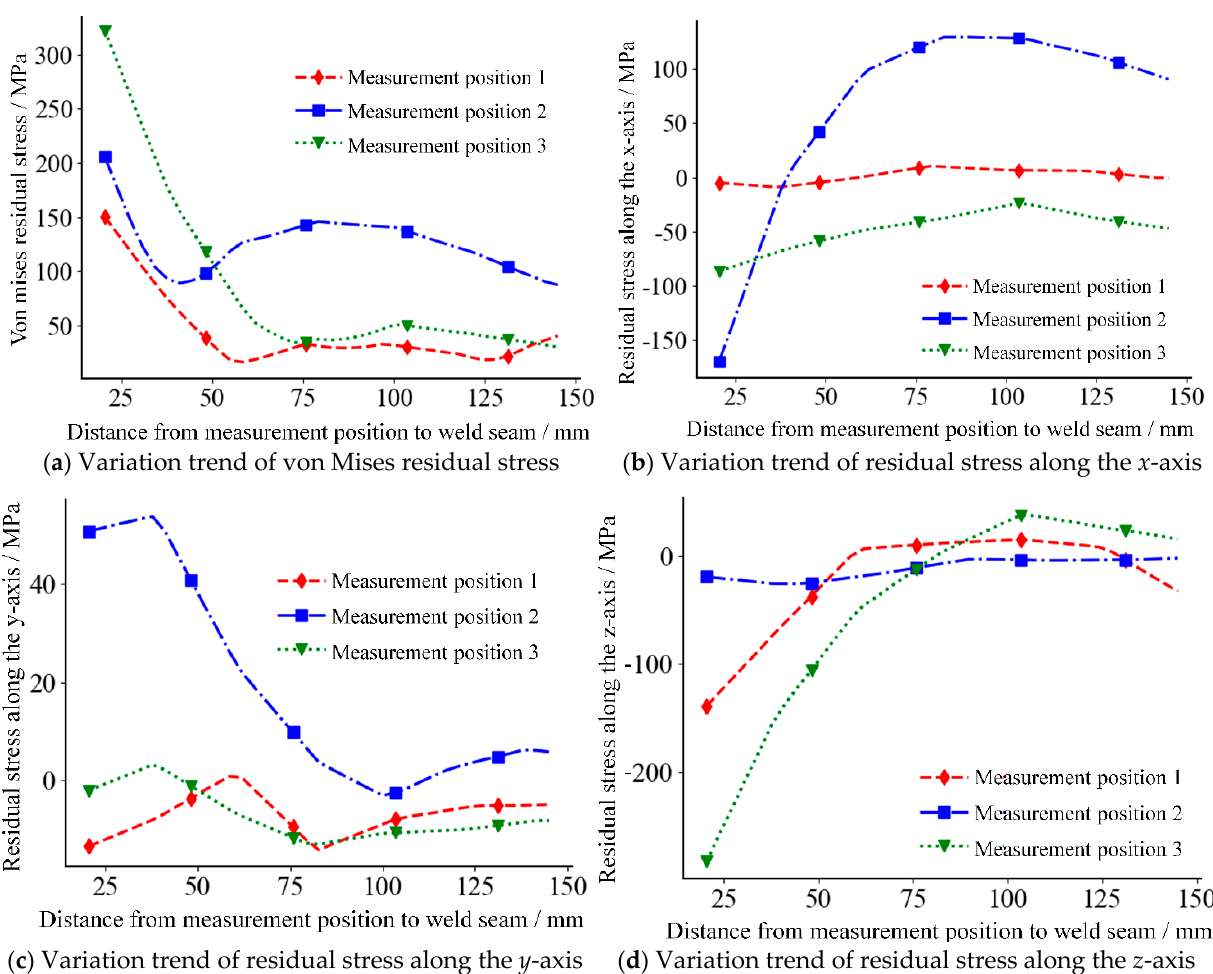
Figure 16. Stress variation trend of welded structure 4 at different positions in the welding sequence of “ ③⑤⑥④②⑦①⑧ ”.